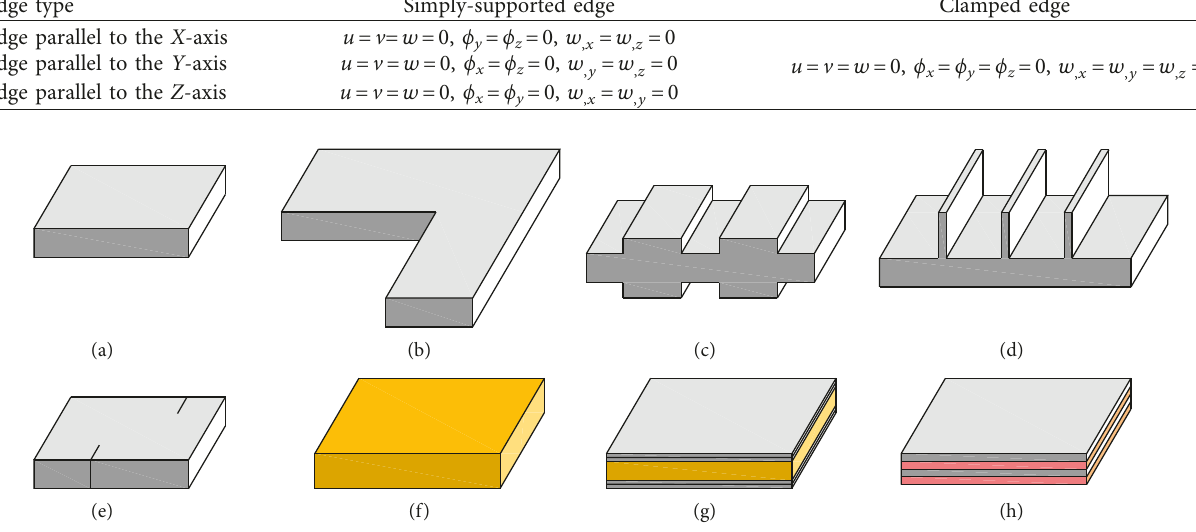
Figure 3: Structural problems which can be analyzed using the proposed computational framework. GUI